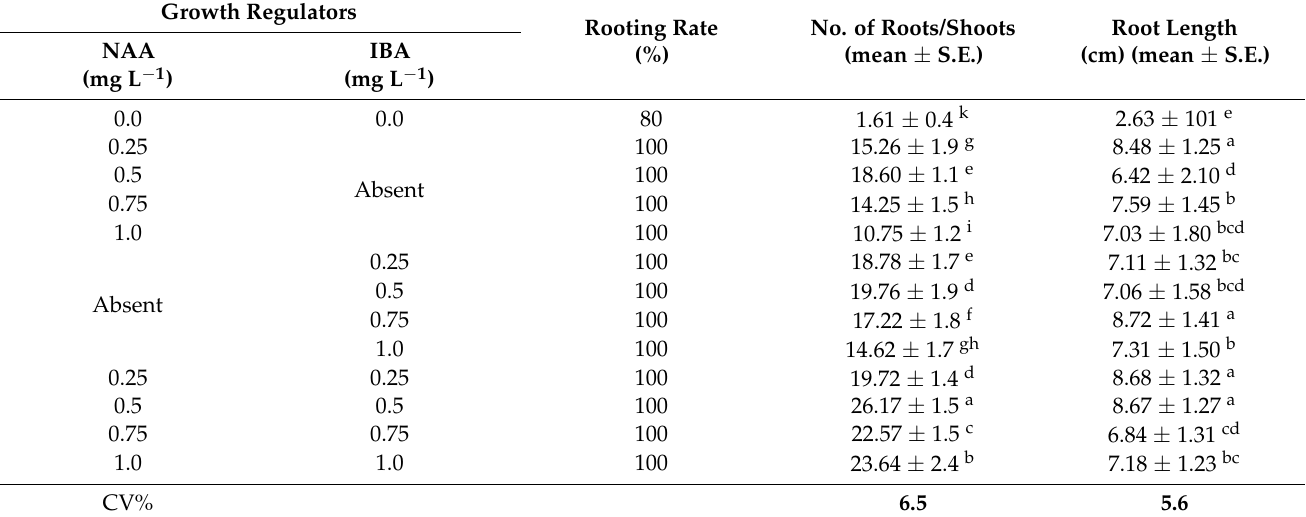
Different letter designations (a–k) in the same column indicate a significant difference at the 95% confidence level. The values represent mean ± standard deviation.